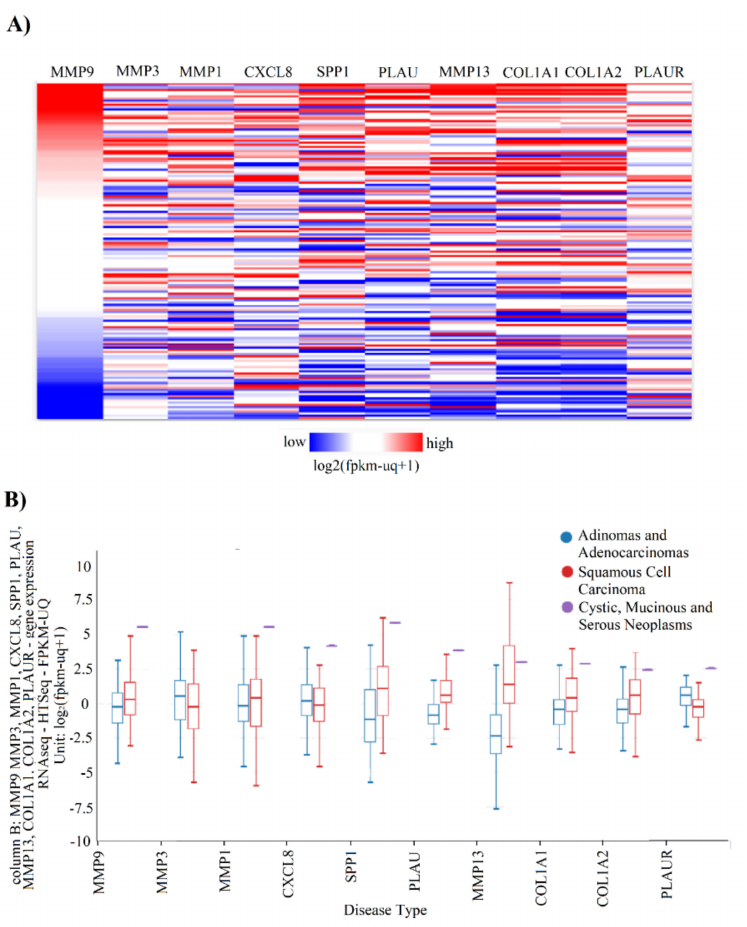
Figure 4. The HGsT10 gene expression using the UCSC Xena database. ( A ) The HGsT10 gene expression using RNAseq-HTseq based on the Fragments Per Kilobase of transcript per Million mapped reads upper quartile. ( B ) The HGsT10 gene expression compared with the subgroups based on the disease type. The HGsT10 upregulated genes were shown in red, and downregulated genes were blue. Abbreviation: HT-Seq-FPKM-UQ: High throughput sequencing-Fragments Per Kilobase of transcript per Million mapped reads upper